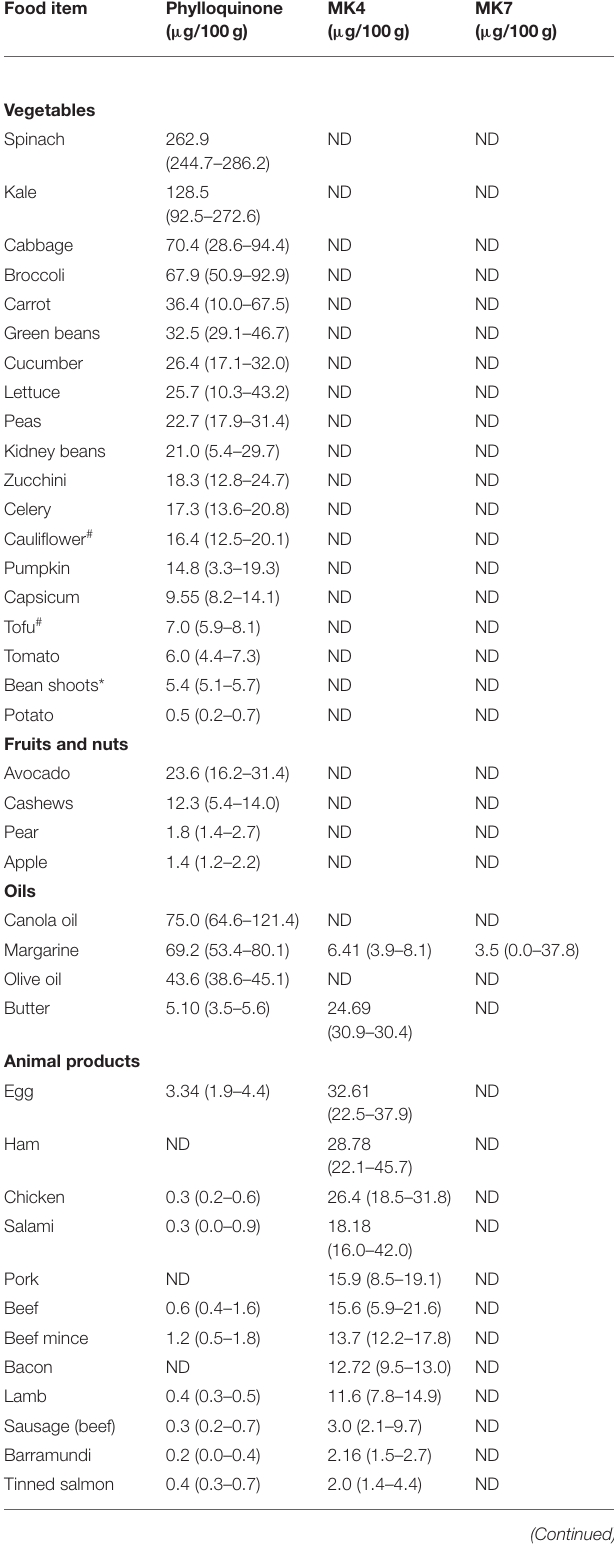
TABLE 2 | Median (range) values of the phylloquinone and menaquinone content of commonly consumed foods obtained from Australian supermarkets.